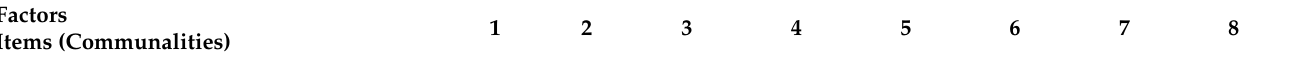
Table 6. The eight-factor solution of the Icelandic BHS-TR